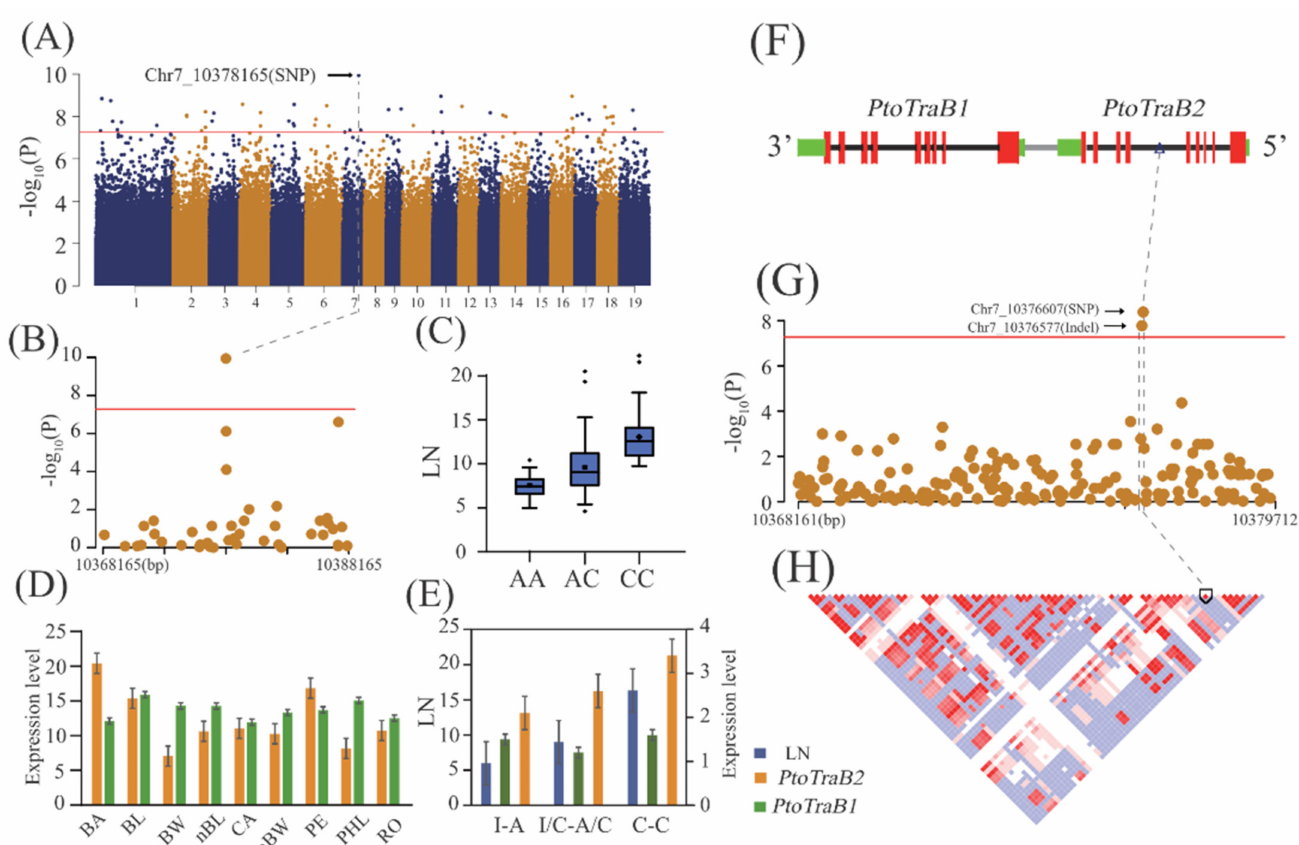
Figure 4. PtoTraB2 plays an important role in the genetic regulation of LN in Populus tomentosa . ( A ) Manhattan plots of LN. The arrow indicates the signal containing the candidate genes (Chr7_10378165). ( B ) Regional association plot of Chr7_10378165. ( C ) Box plot of genotype effects of SNP Chr7_10378165 for LN. ( D ) Expression patterns of PtoTraB1 and PtoTraB2 in nine tissues of P. tomentosa. BA, bark; BL, mature leaves; BW, mature xylem; nBL, developing leaves; CA, cambium; nBW, developing xylem; PE, phloem; PHL, phloem; RO, root. ( E ) Effects of haplotype on LN and PtoTraB1 and PtoTraB2 expression, where “I” represents the wild-type (WT) locus (CTTATTTCT). ( F ) Gene structure of PtoTraB1 and PtoTraB2 . Red, black, and green rectangles represent the exon, intron, and 3 (cid:48) UTR/5 (cid:48) UTR sequences. ( G ) Regional association plot of PtoTraB1 and PtoTraB2 , including SNPs and InDels. ( H ) LD representation of pairwise r 2 values among all polymorphic sites (SNPs and InDels) across the PtoTraB1 and PtoTraB2 locus, where darker red areas indicate higher r 2